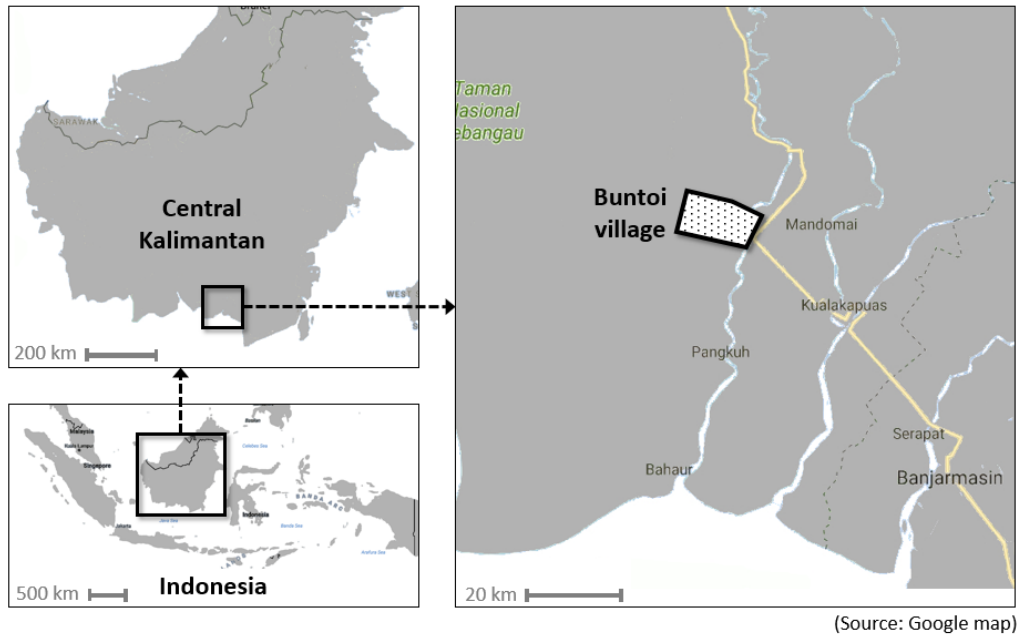
Figure 1. Location of Buntoi village, Central Kalimantan, Indonesia.